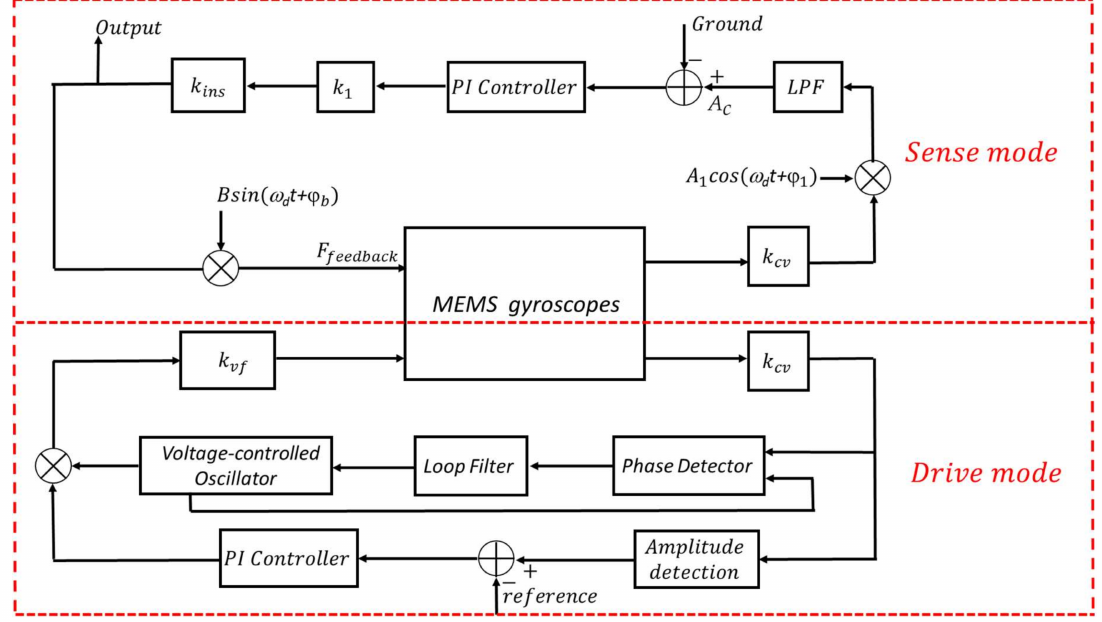
Figure 4. The closed-loop simulation diagram of MEMS